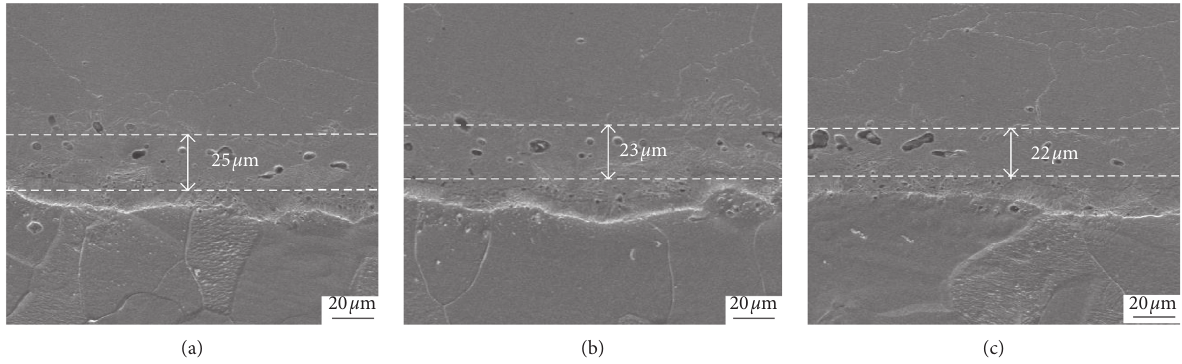
Figure 11: SEM morphology of the bonding layer with 70% reduction rate (500x). (a) Area I. (b) Area II. (c) Area